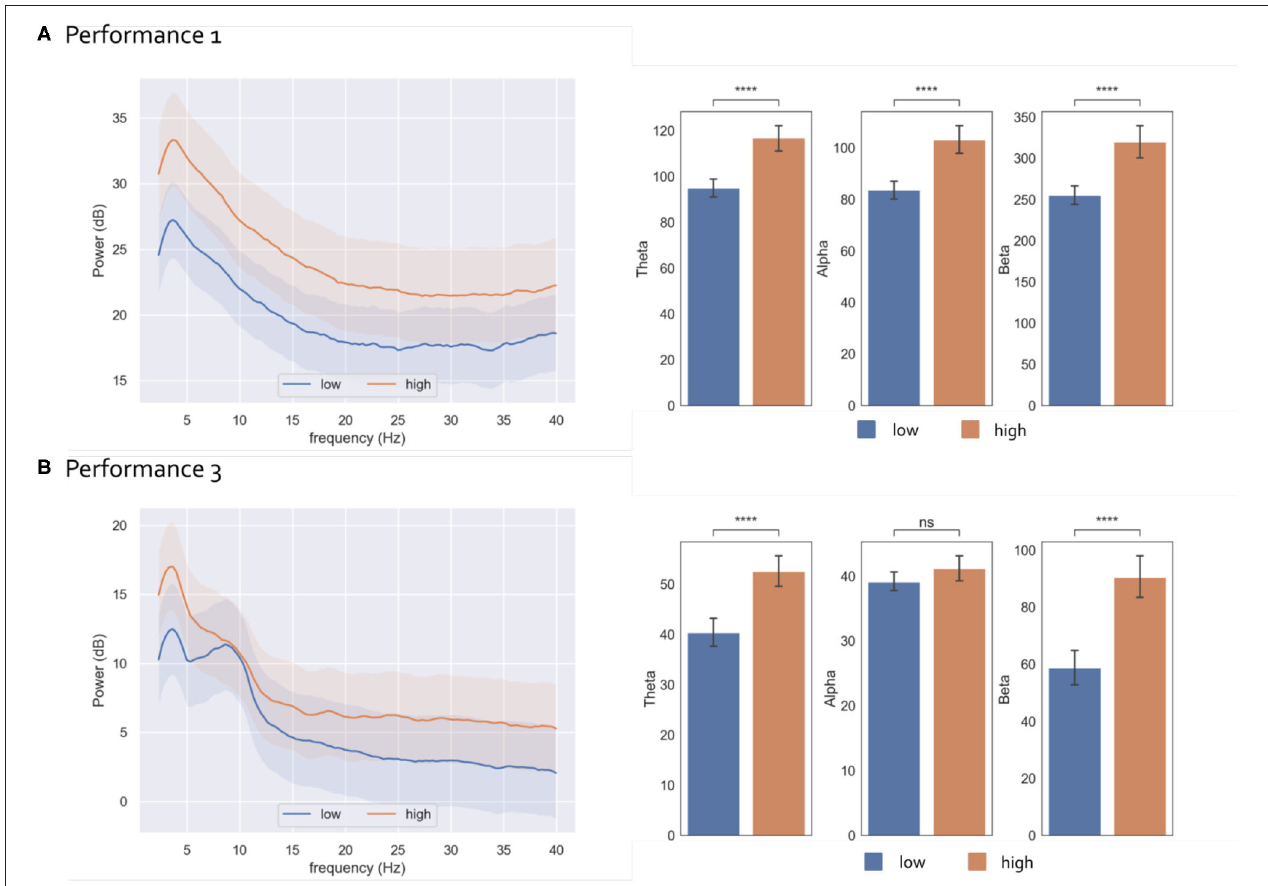
FIGURE 3 | Ecological Paradigm: Results of EEG post-hoc frequency analysis in relation to STR for performance 1 (A) and performance 3 (B) Results represent EEG power averaged across electrodes. Left: EEG Power Spectral Density (mean across 3 s epochs) corresponding to low (blue) and high (orange) states, with 95% confidence intervals. Right: Bar plots representing the EEG power (mean ± std) in the Theta, Alpha and Beta bands in low and high states. Square brackets indicate significant differences as assessed with pair-wise two-sided Welch t -test (**** p <